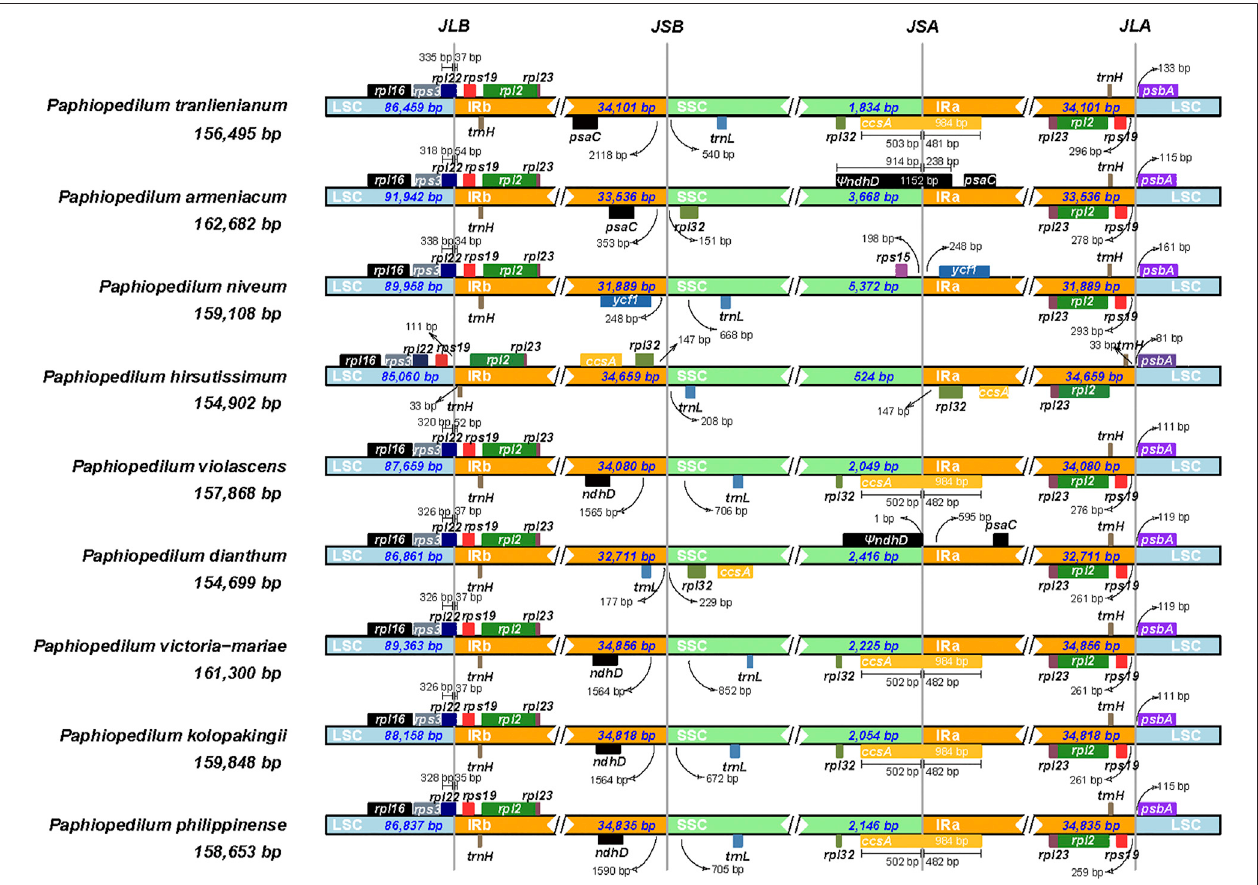
FIGURE 7 | Comparison of junctions between single-copy and inverted repeat regions in the chloroplast genomes of nine Paphiopedilum species. The genes transcribedfromrighttoleftaredepictedonthetopoftheircorrespondinglocus;genestranscribedfromlefttorightaredepictedbelow.Thearrowsindicatethedistance between the start or end of a given gene and the corresponding junction site. JLB (LSC/IRb), JSB (IRb/SSC), JSA (SSC/IRa), and JLA (IRa/LSC) denote four junctions between the two single-copy regions (LSC and SSC) and the two IRs (IRa and IRb).